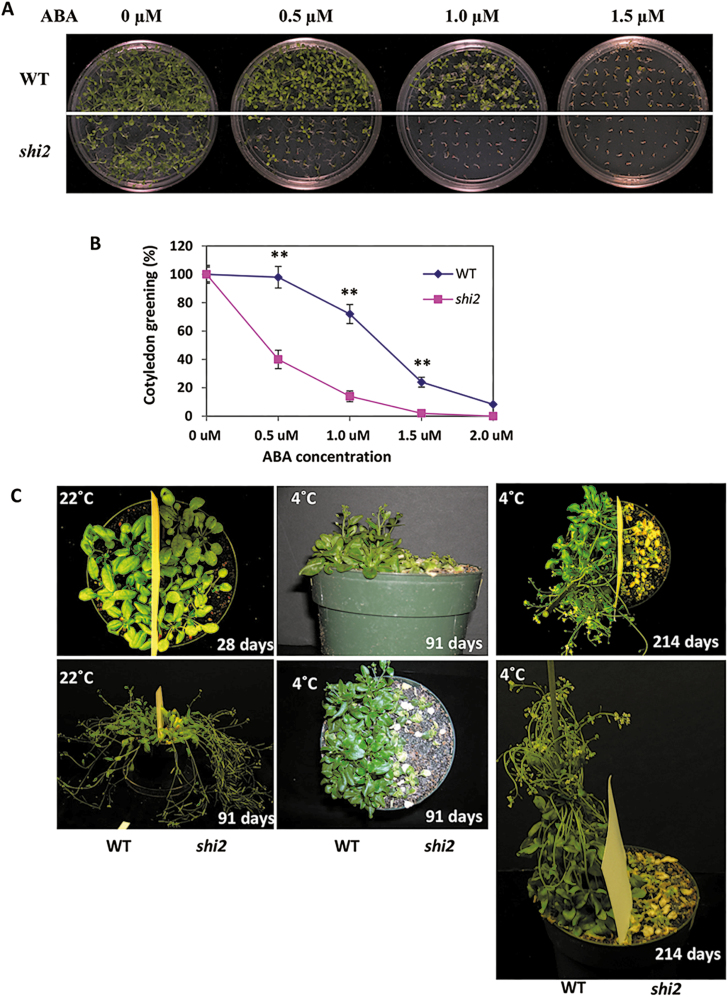

shi2 is hypersensitive to ABA and shows a growth defect under cold conditions. (A) Images showing seed germination of the wild type and shi2 mutant in 1/2 MS medium containing different concentrations of ABA. (B) Quantitative measurement of cotyledon greening at 12 d after seed germination. Asterisks indicate a statistically significant difference; the same experiment was repeated three times (n=3, **P<0.01 by Student’s t-test). (C) Images showing increased growth inhibition of the shi2 mutants under cold stress conditions. Seven-day-old seedlings grown in 1/2 MS agar medium were transferred to soil and grown for an additional 10–14 d under normal growth conditions. These plants were then placed in a 4 °C cold room for 91 d and 214 d with continuous light. (This figure is available in color at JXB online.)